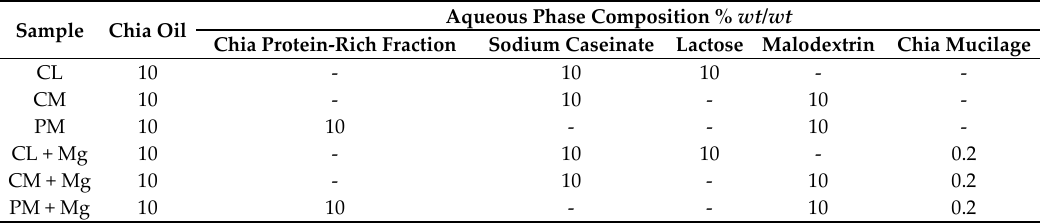
Table 1. Composition of chia oil-in-water (O/W)